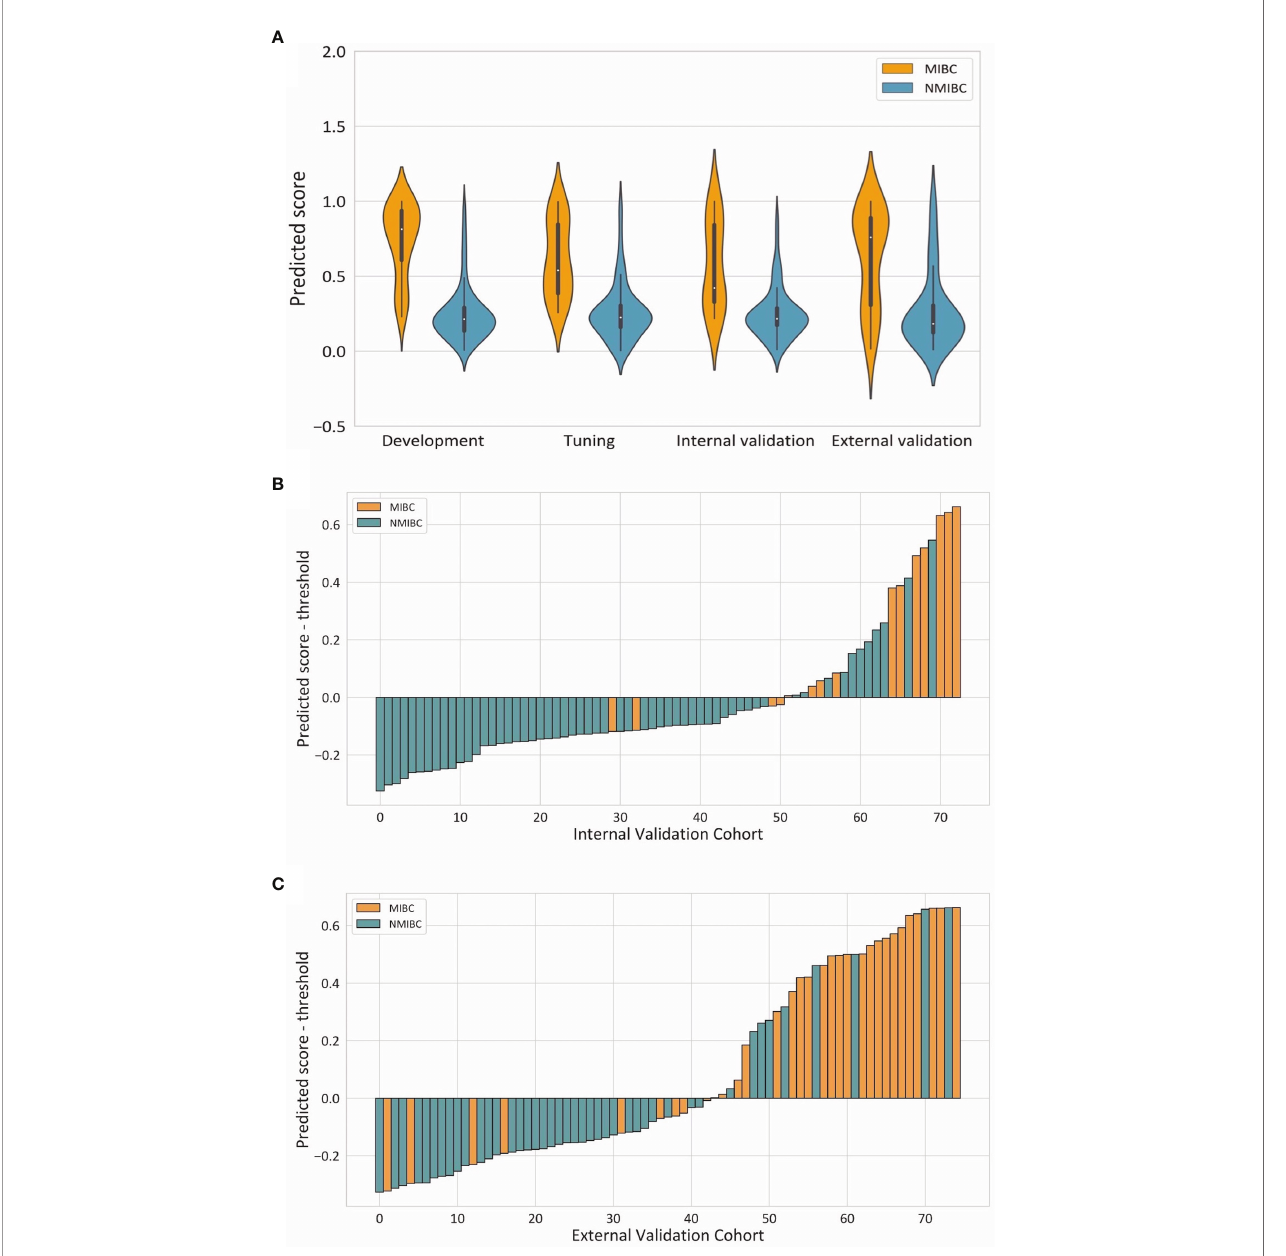
FIGURE 4 | Illustrations of the performance of the deep learning model. (A) Violin plots of predictive scores in the development, tuning, internal validation and external validation cohorts. (B, C) showed waterfall plots of the distribution of predictive scores and muscle invasive status of each patient in the internal and external validation cohorts